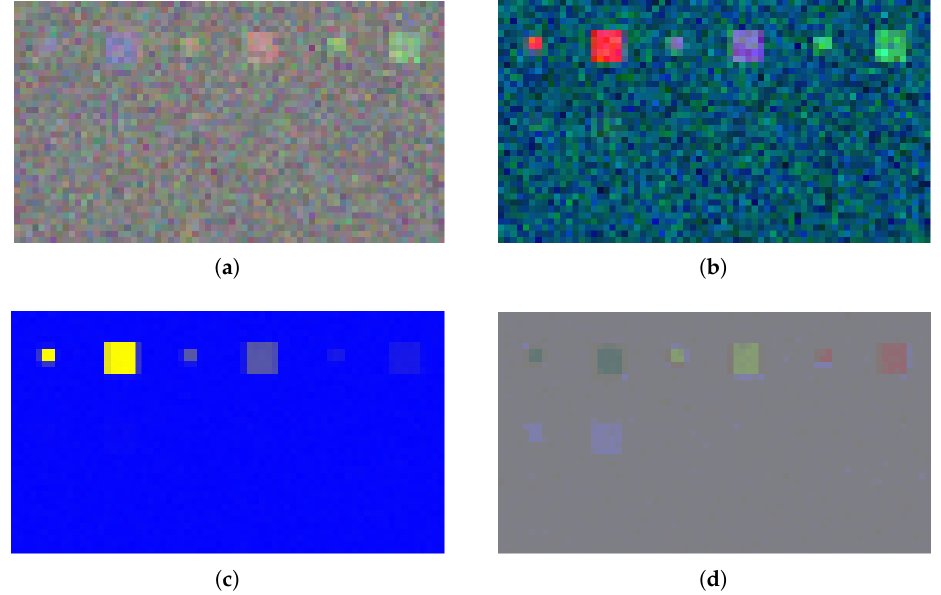
Figure 6. RGB images obtained by the projection of the results produced with the different dimen- sionality reduction techniques at the instant 5 s in the thermal sequence: ( a ) ICA, ( b ) PCA, ( c ) MNF, ( d )